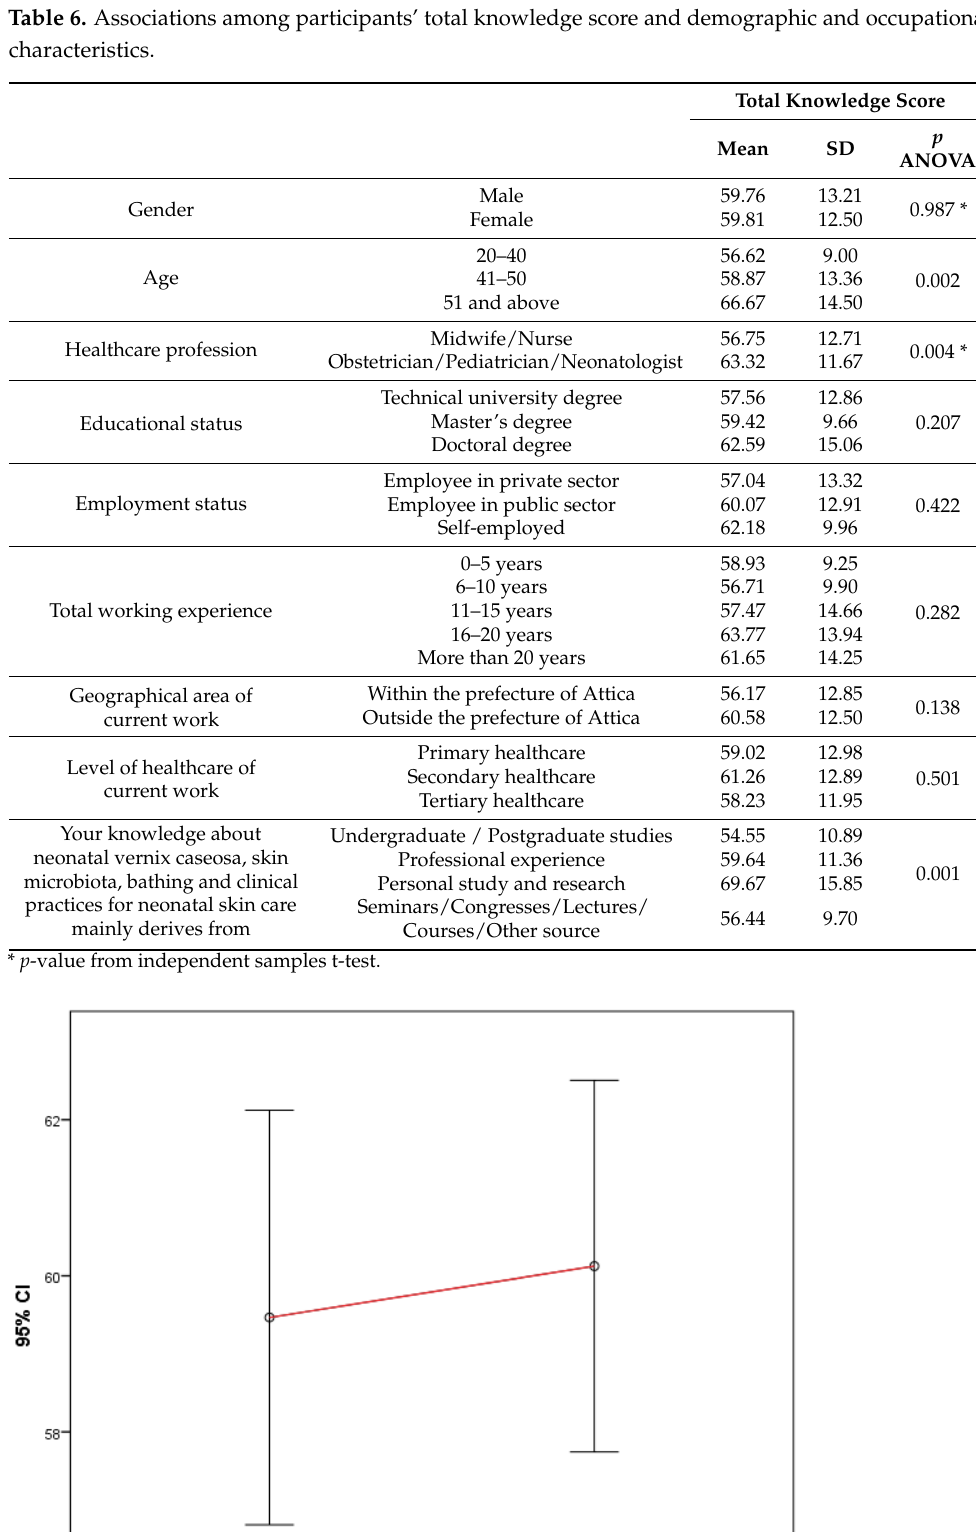
Pearson’s correlation coefficient (r) between theoretical and clinical knowledge scores is presented in Table 7. Table 7. Correlation between theoretical and clinical knowledge scores.